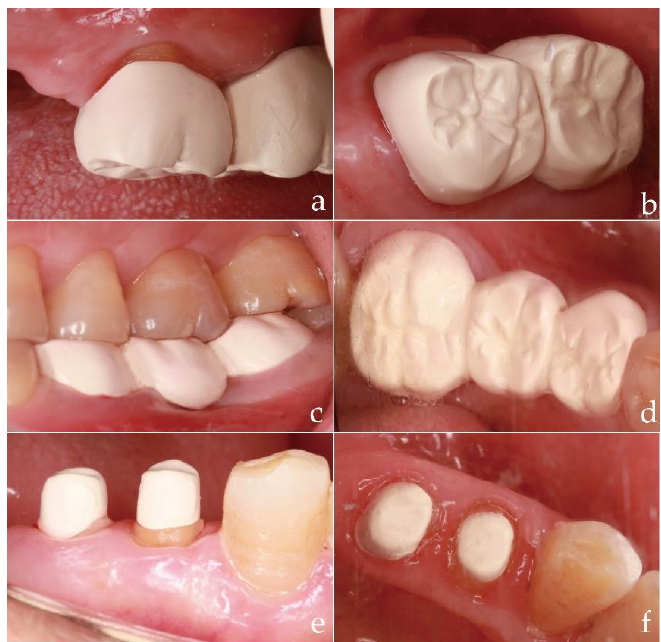
Figure 1. Clinical photographs of PEEK prostheses: ( a ) Frontal view of PEEK crowns; ( b ) Occlusal view of PEEK crowns; ( c ) Frontal view of PEEK fixed partial dentures; ( d ) Occlusal view of PEEK fixed partial dentures; ( e ) Frontal view of PEEK post-and-core; ( f ) Occlusal view of PEEK post-and-core.